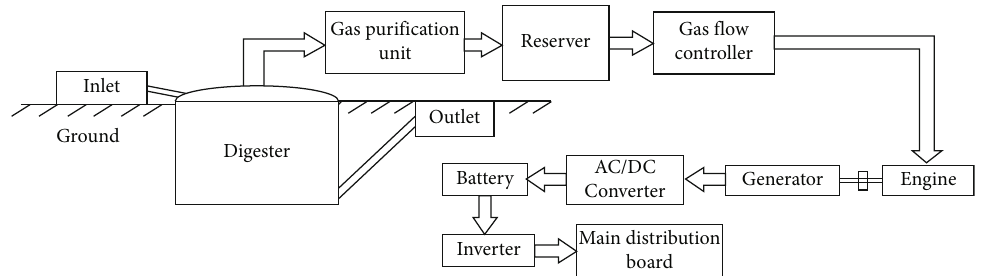
Figure 3: Block diagram of a typical grid-connected biogas electricity